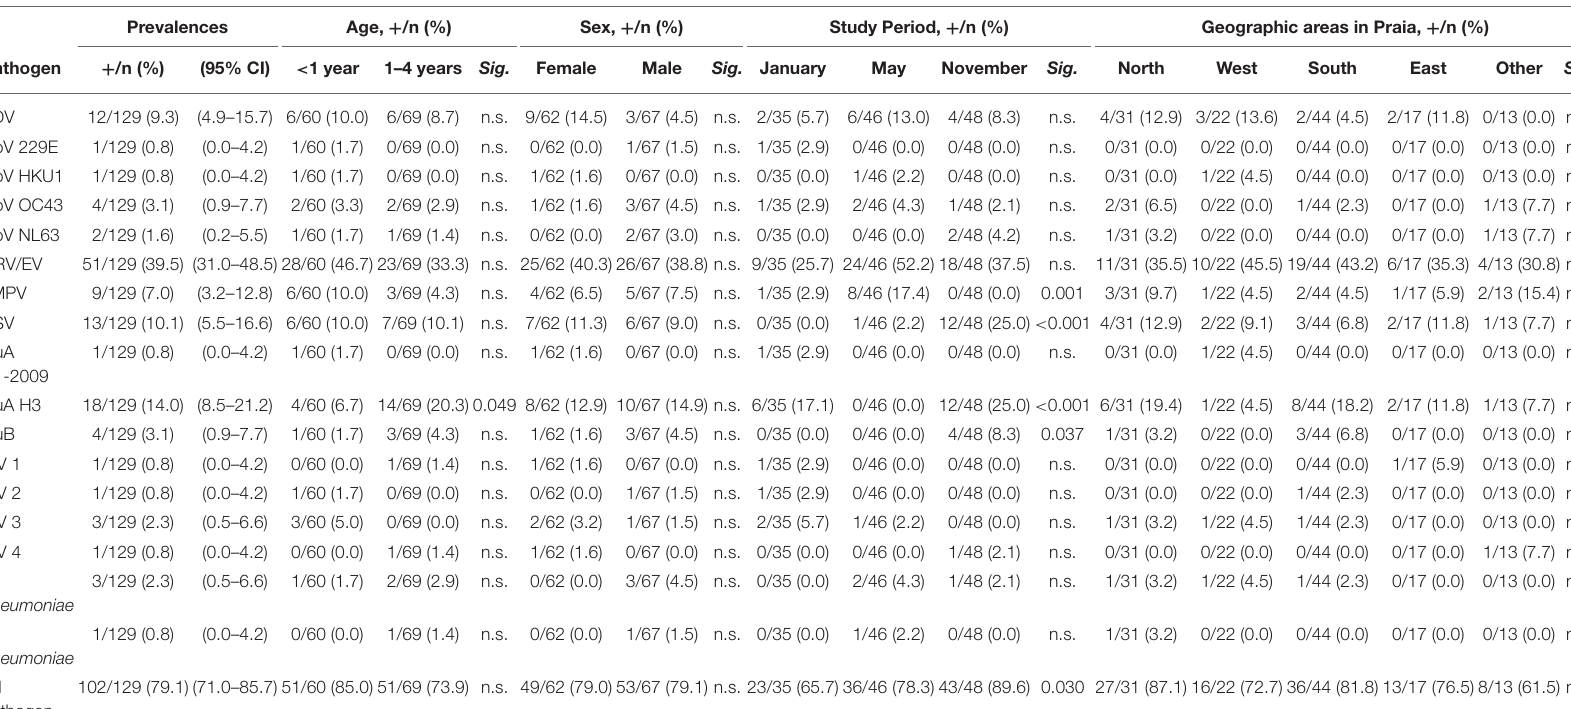
TABLE 1 | Frequency (%) of respiratory pathogens by age, sex, study period and geographic areas in Praia, during 2019. Prevalences Age, + /n (%) Sex, + /n (%) Study Period, + /n (%) Geographic areas in Praia, + /n (%) Pathogen Female Male Sig. January May November Sig. North West South East Other